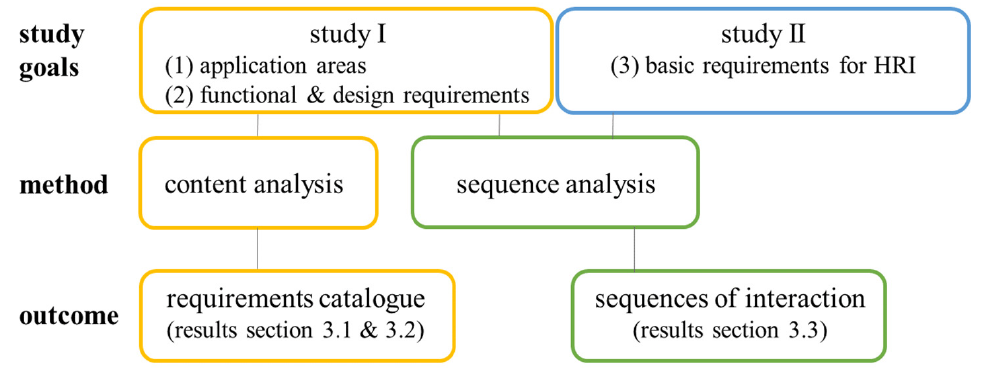
Figure 1. General procedure, aims, methods, and outcome of analyses of the two consecutive